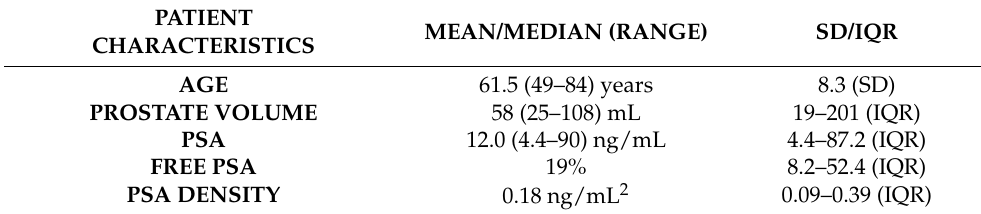
Table 2. Patient characteristics: characteristics of the 431 patients selected in the study.